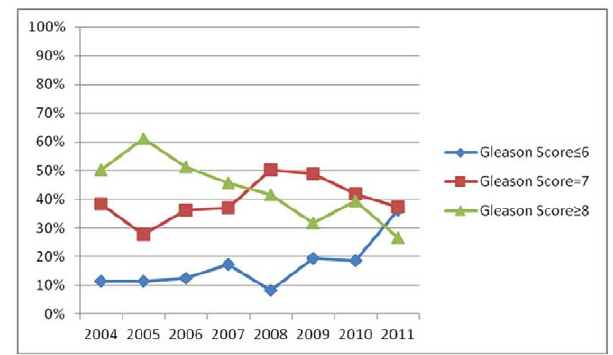
Figure 1. The percentage of tPSA levels over 20 ng/mL in PCa patients. There was a significant decrease in the percentage of tPSA levels over 20 ng/mL in PCa patients from 2003 to 2010 ( P trend =2.26 6 10 2 5 ).